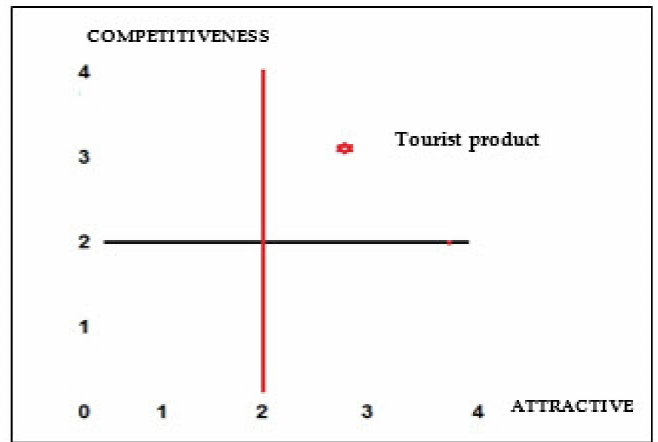
Figure 8. Competitiveness and attractiveness of the tourism product. Source: own elaboration based on the results of the SWOT